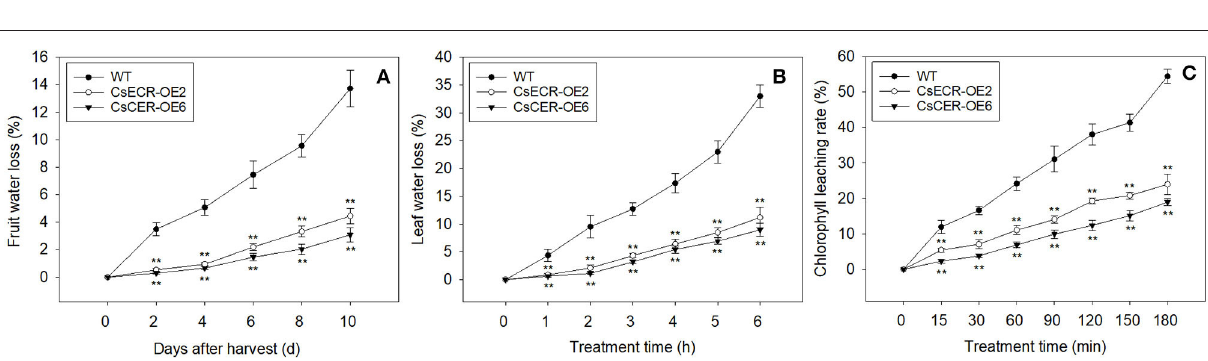
FIGURE 7 | Analyses of cuticular permeability in the fruits and leaves from the WT and two transgenic tomato lines (CsECR-OE2 and CsECR-OE6). (A) The water loss of fruits and (B) leaves in the WT and two transgenic tomato lines. (C) The chlorophyll leaching rates in the leaves of the WT and two transgenic tomato lines. Vertical bars represent standard deviations of the means ( n = 3). Significant differences between the WT and transgenic tomato lines at the P < 0.01 levels were indicated by double asterisks according to Student’s t